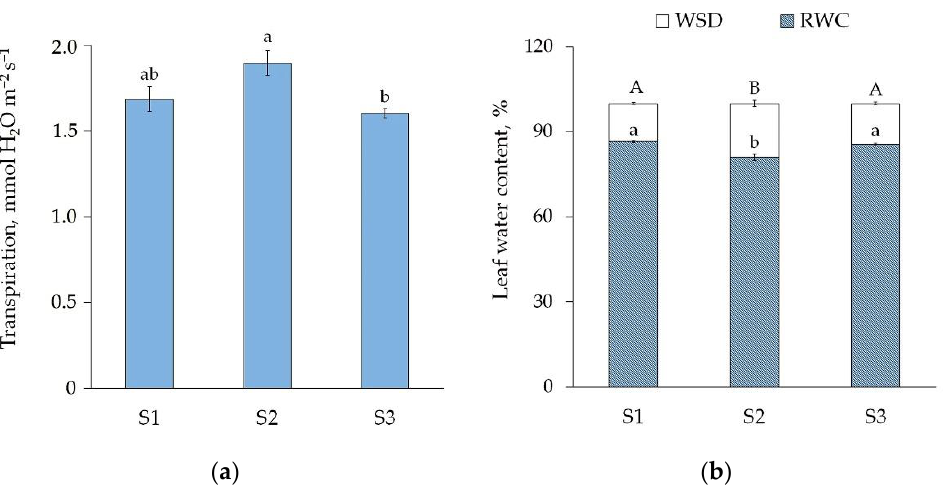
Figure 5. The water status parameters of E. atrorubens growing on serpentine substrates: ( a ) Transpiration rate; ( b ) Relative water content (RWC) and water saturation deficit (WSD). Data is presented as Means ± SE ( n = 12). Different alphabetical letters indicate a significant difference between the studied populations at p < 0.05.